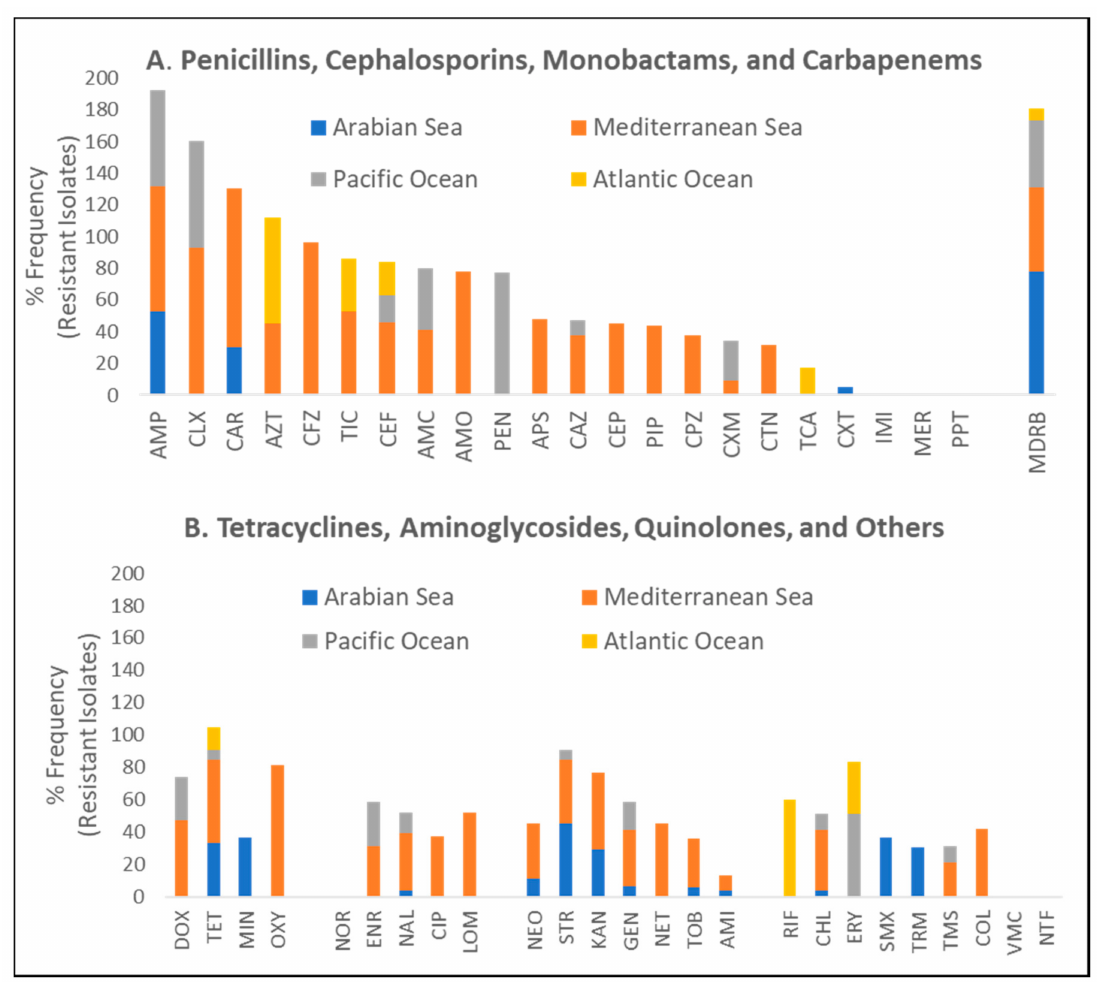
Figure 4. Frequency distribution of AR against commonly used antibiotics stratified by geographical marine environ- ment irrespective of biological specimen considered, bacterial isolates, or turtle species for beta-lactams ( A ) and other antibiotic classes ( B ). Abbreviations are defined as: AMI = Amikacin; AMO = Amoxicillin; AMC = Amoxicillin-clavulanic acid; AMP = Ampicillin; APS = Ampicillin-salbactam; AZT = Aztreonam; CAR = Carbenicillin; CAZ = Ceftazidime; CEF = Ceftiofur; CEP = Cefepime; CFZ = Cefazolin; CIP = Ciprofloxacin; CLX = Cefalexin; CHL = Chloramphenicol; COL = Colistin; CTN = Ceftriaxone; CXM = Cefotaxime; CXT = Cefoxetin; DOX = Doxycycline; ENR = Enrofloxacin; ERY = Erythromycin; RIF = Rifampicin; GEN = Gentamicin; IMI = Imipenem; LOM = Lomefloxacin; MDRB = percentage of multi-drug resistant isolates; MER = Meropenem; MIN = Minocycline; KAN = Kanamycin; NAL = Nalidixic acid; NET = Netlimicin; NFT = Nitrofurantoin; NEO = Neomycin; NOR = Norfloxacin; PEN = Penicillin; OXY = Oxytetracycline; PIP = Piperacillin; PPT = Piperacillin-tazobactam; STR = Streptomycin; SMX = Sulfamethoxazole; TCA = Ticarcillin- clavulanic acid; TET = Tetracycline; TIC = Ticarcillin; TOB = Tobramycin; TRM = Trimethoprim; TMS = Trimetho- prim/sulfamethoxazole; VMC =